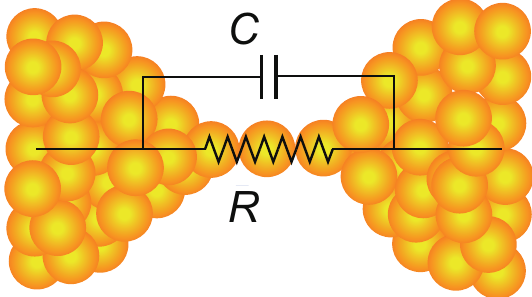
Figure 2. Classical resistor-capacitor ( RC ) model of a single-atom